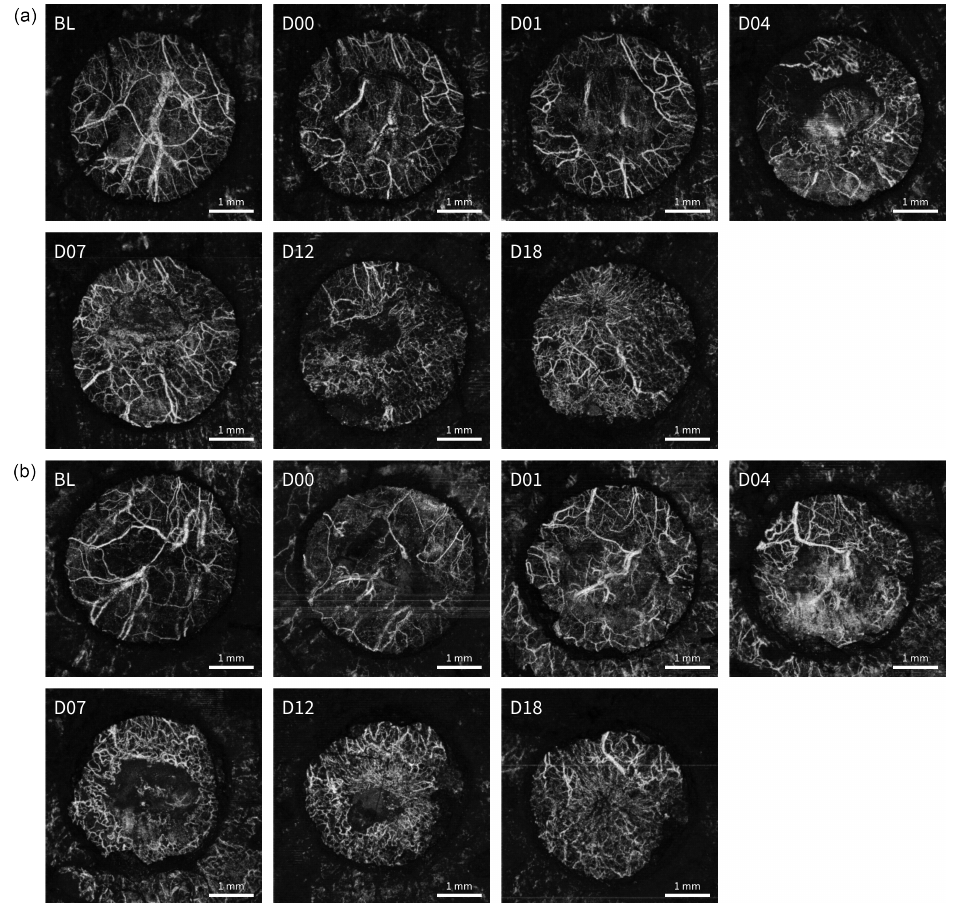
Figure 3. Optical coherence tomography angiography of dermal wound healing. Images present the angiogram time series of ( a ) one non-diabetic and ( b ) one diabetic animal. While the depicted non-diabetic mouse belonged to the control group that received no treatment, the diabetic animal received fibrin sealant at each study day directly after OCT measurements. BL is the baseline measurement before and D00 the measurement directly after wounding. D01 to D18 denote the angiograms acquired on the following days until the last study day